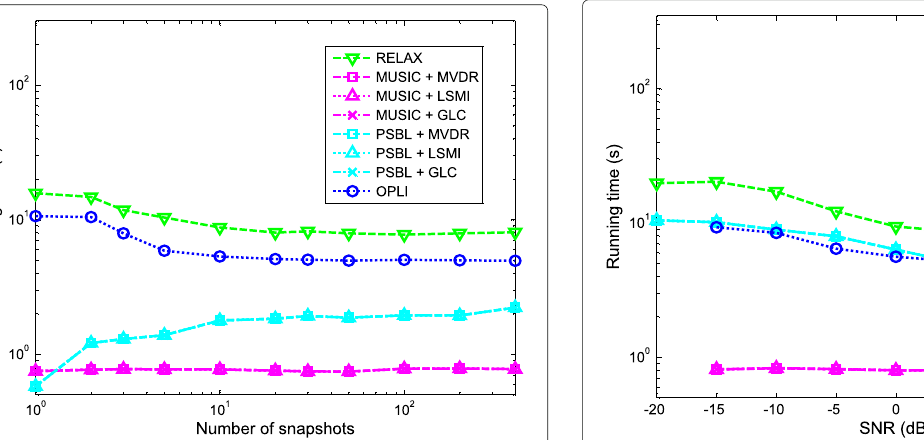
signals are considered, the input SNR is fixed at 10 dB, and L = 200 snapshots are employed. The SOI impinges from